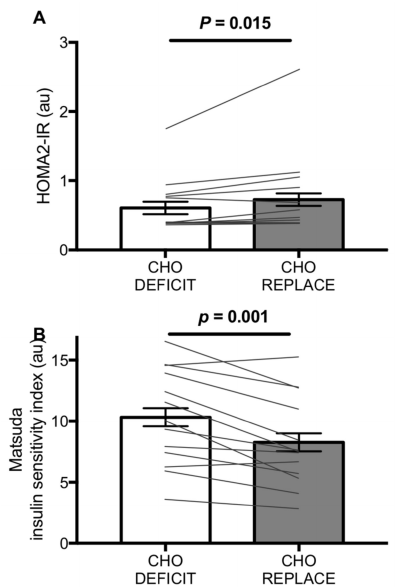
Figure 3. Homeostasis model of insulin resistance (HOMA2-IR) ( A ) and the Matsuda insulin sensitivity index ( B ) during the oral glucose tolerance test conducted ~16 h after exercise with either carbohydrate replacement (CHO-REPLACE) or a maintenance of the exercise-induced carbohydrate deficit (CHO-DEFICIT). n = 13. Data are means ± normalized 95%